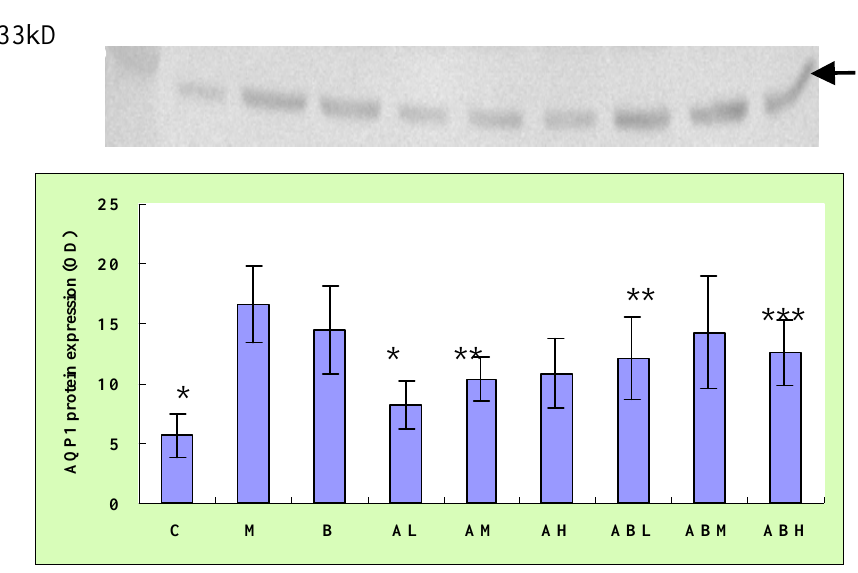
Figure 1. The AQP1 protein level in the lung specimen of each group. Arrow points to the 28 kD AQP1 protein. C: normal, M: tumor model, B: NaHCO , AL: acetazolamide 20 mg/kg, AM: 3 acetazolamide 40 mg/kg, AH: acetazolamide 80 mg/kg, ABL: acetazolamide 20 mg/kg and NaHCO mg/kg, ABM: acetazolamide 40 mg/kg and NaHCO 30 mg/kg, ABH: acetazolamide 80 mg/kg and 3 NaHCO 30 mg/kg. n = 6-9, mean±SD, *p < 0.001, **p < 0.01 ***p < 0.05 vs 3